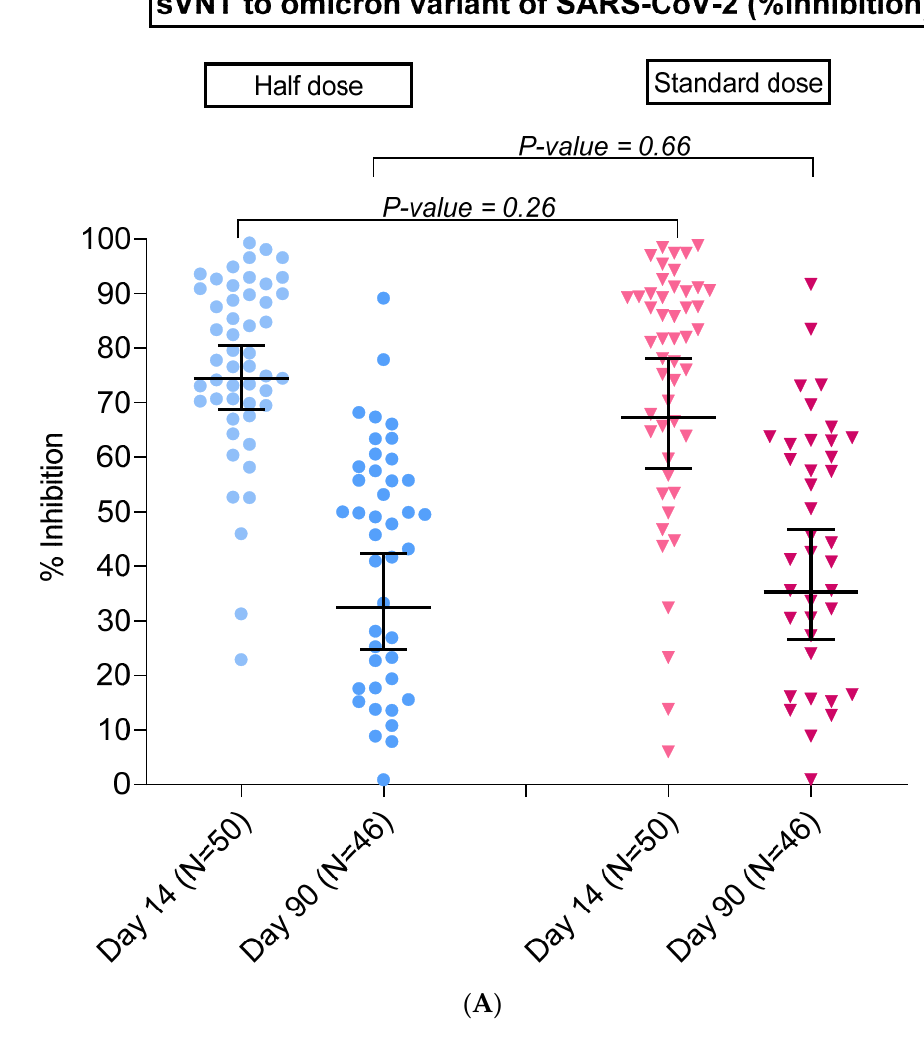
Table 2. Results of sVNT for variants of concern and anti ‐ S ‐ RBD IgG at day 14 and day 90 among adults who received half ‐ dose or standard ‐ dose BNT162b2 booster.